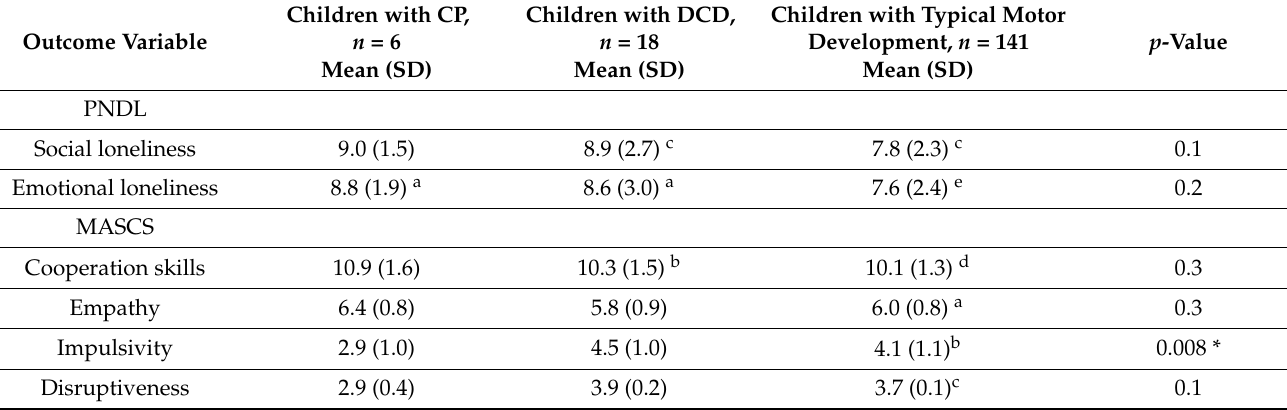
Table 4. Perceived loneliness assessed with the Peer Network and Dyadic Loneliness scale (PNDL) and social competence assessed with the Multisource Assessment of Children’s Social Competence Scale (MASCS) in children born very preterm with cerebral palsy (CP), with developmental coordina- tion disorder (DCD) and with typical motor development at 11 years of age. Higher scores indicate higher loneliness, co-operative skills, empathy, impulsivity, or disruptiveness. ANOVA was used to study the differences in the mean values between the